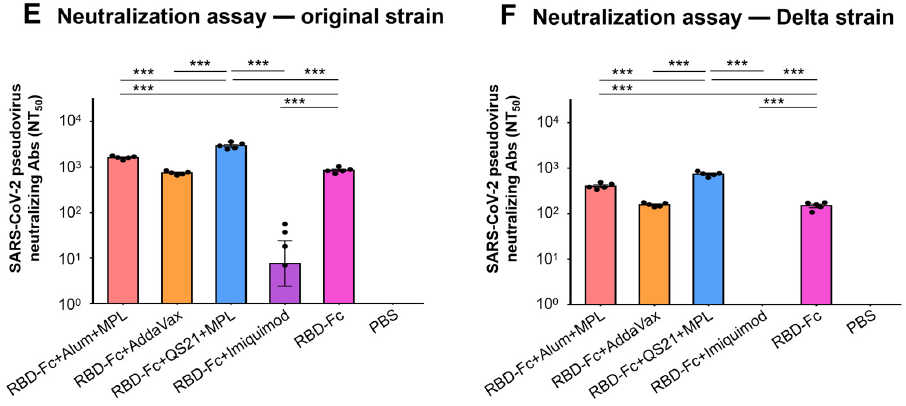
Figure 1. Design and evaluation of SARS-CoV-2 RBD-based subunit vaccine in the presence or absence of various adjuvants. SARS-CoV-2 RBD-Fc protein was expressed in HEK293F cells and purified from cell culture supernatants. The boiled and non-boiled SARS-CoV-2 RBD-Fc proteins were subjected to SDS-PAGE ( A ) followed by Western blot ( B ) with the sera from mice immunized with the wild-type RBD protein without Fc fragment of human IgG. Then, five B6 mice in each group were immunized with the protein twice, 3 weeks apart, in the presence or absence of various adjuvants. Ten days after final immunization, mice sera were collected and analyzed for SARS-CoV-2 RBD-specific antibody ( C ) and SARS-CoV-2 S protein-specific antibody ( D ) using ELISA. Furthermore, the neutralizing antibodies against SARS-CoV-2 original strain ( E ) and Delta strain ( F ) were also detected using pseudovirus, 293T-hACE2 cell line, and neutralization assay. NT 50 was the dilution times of mice sera (neutralizing antibody titers) by which the pseudovirus infection in the 293T-hACE2 cells was neutralized by 50%. The data in the figure are expressed as mean ± SEM, and statistical significance was tested using ordinary one-way ANOVA and Tukey’s multiple comparisons test . Asterisks (*** and **) denote p values less than 0.001 and 0.01, respectively. The experiments were